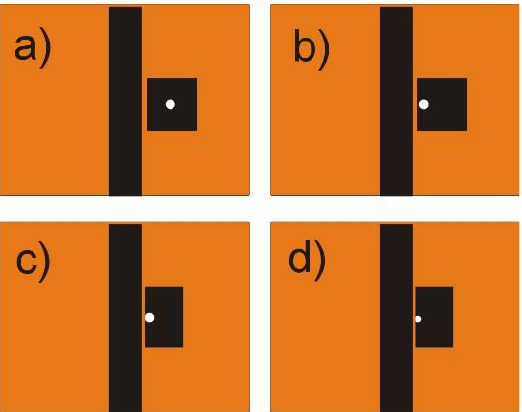
Figure 3. Strategy for EBG resonator miniaturization, steps to compact the element: ( a ) square patch with centered metallic via, ( b ) square patch with lateral metallic via, ( c ) rectangular patch with longer capacitive coupling and ( d ) metallic cylindrical shorting element (metallic via) with lower radius.